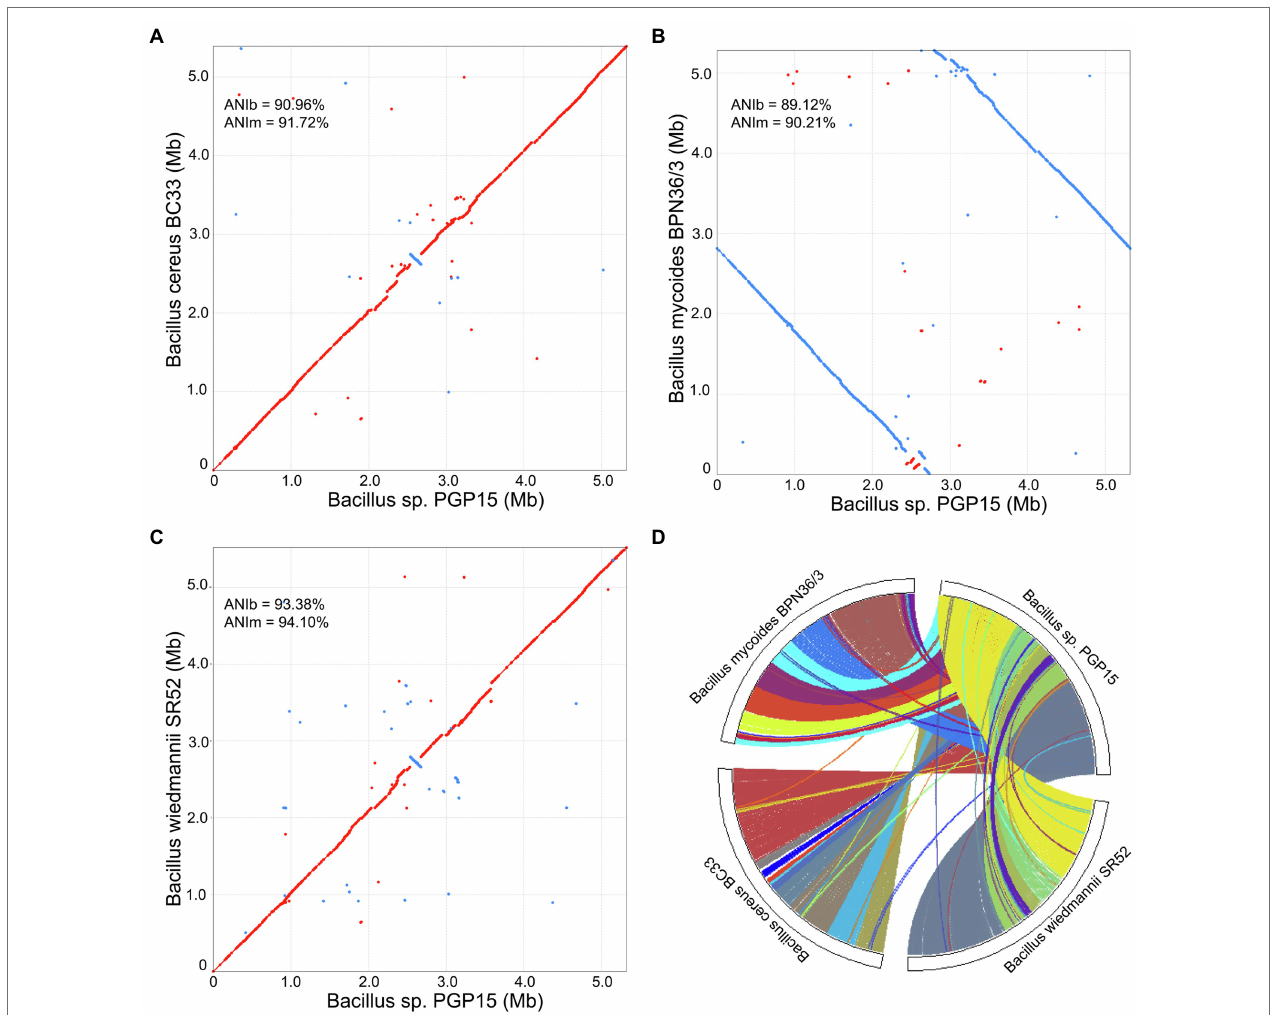
FIGURE 6 | Collinearity analysis of chromosomes of strains PGP15, B. cereus BC33, B. wiedmannii SR52, and B. mycoides BPN36/3. (A–C) Complete genome alignments of strain PGP15 against B. cereus BC33 (A) , B. mycoides BPN36/3 (B) , and B. wiedmannii SR52 (C) using Mummer software. Red and blue dots represent forward and reverse matches, respectively. The average nucleotide identity (ANI) was analyzed by pairwise comparison based on Blast (ANIb) and MUMmer (ANIm). (D) Genome synteny of the four strains based on MCScanX analysis, showing the conserved genomic regions shared among them. Each line represents a syntenic block of five or more gene